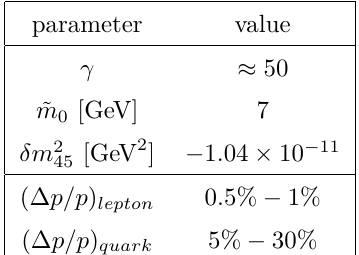
Table 1. Parameters used for simulating the kinematics of the processes in figures 1(a) and 1(b), in order to evaluate the observability conditions for the example minimal low scale seesaw parameter point used in [15]. γ denotes the gamma factor of the heavy neutrinos, ˜ m 0 their mean mass (which in the simulation coincides with m 0 ), and the squared mass splitting δm 2 of [15] is predicted by the measured values of the light neutrino mass splittings. The used range for the uncertainties in the measurement of the momenta of the external charged leptons and jets are denoted as (∆ p/p ) lepton and (∆ p/p ) quark